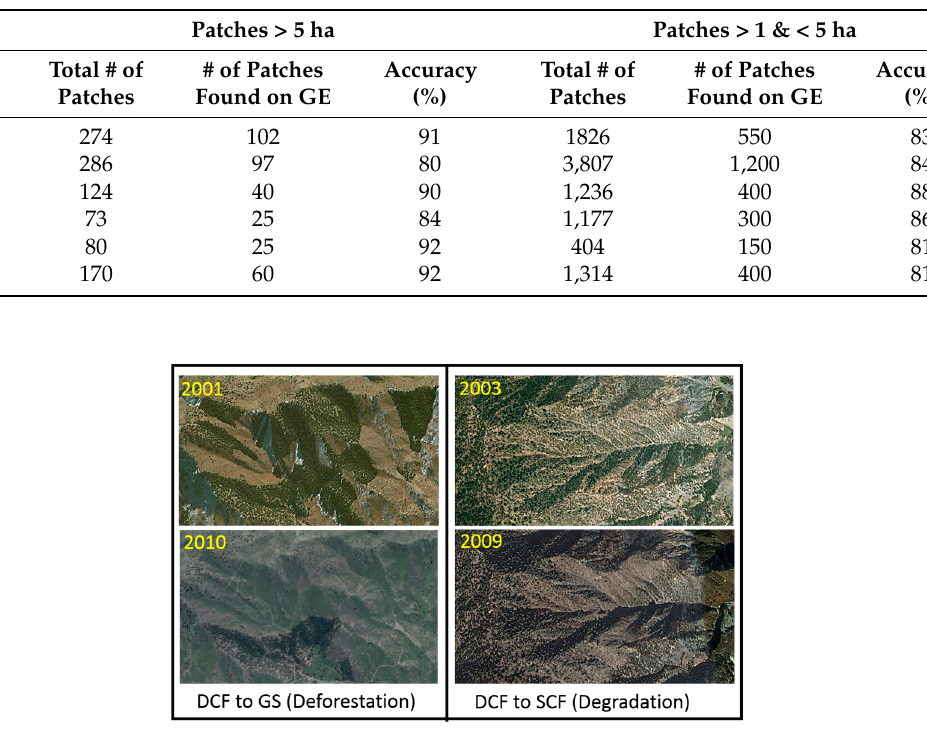
Figure 7. An example of the validation of deforestation and degradation based on Google Earth images.